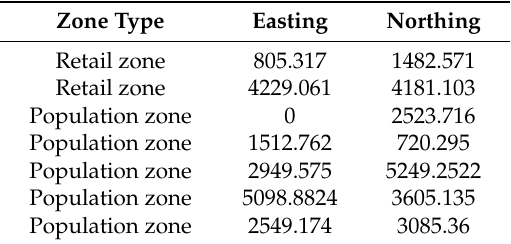
Table A1. Zone centroids for region R1.